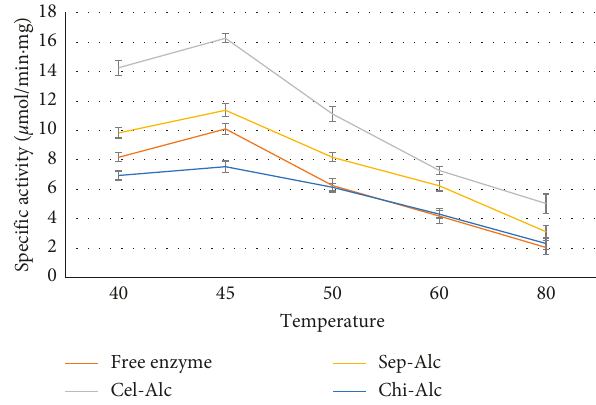
1mg/mL). Figure 3: Specific hydrolytic activity of alcohol-immobilized (cid:31)